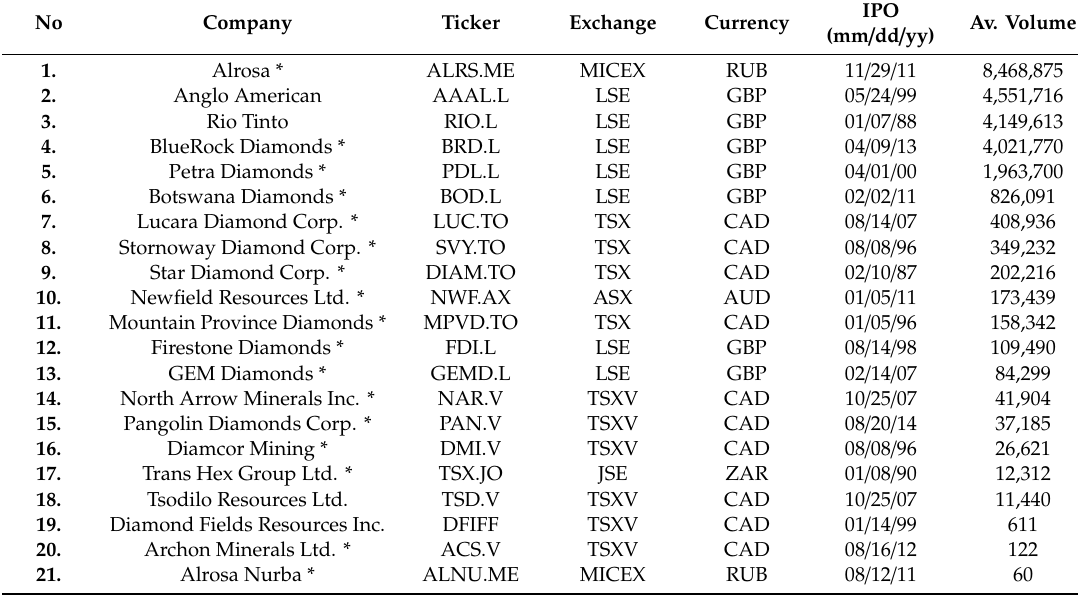
Table 1. Diamond-mining stocks traded at di ff erent exchange markets.